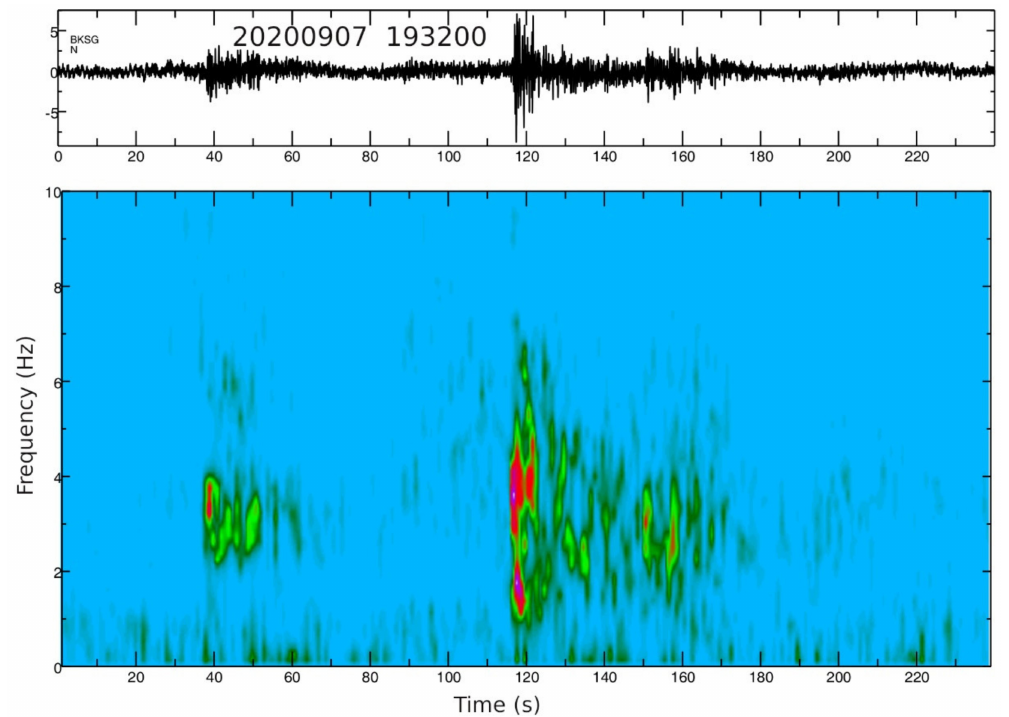
Figure 10. Spectrogram of 202009071932 LF seismic event evaluated on north–south component of BKSG seismic station. Table 1. LF seismic events detected with the proposed procedure applied to continuous seismic signals recorded at Mt. Vesuvius over a 28-month time span.